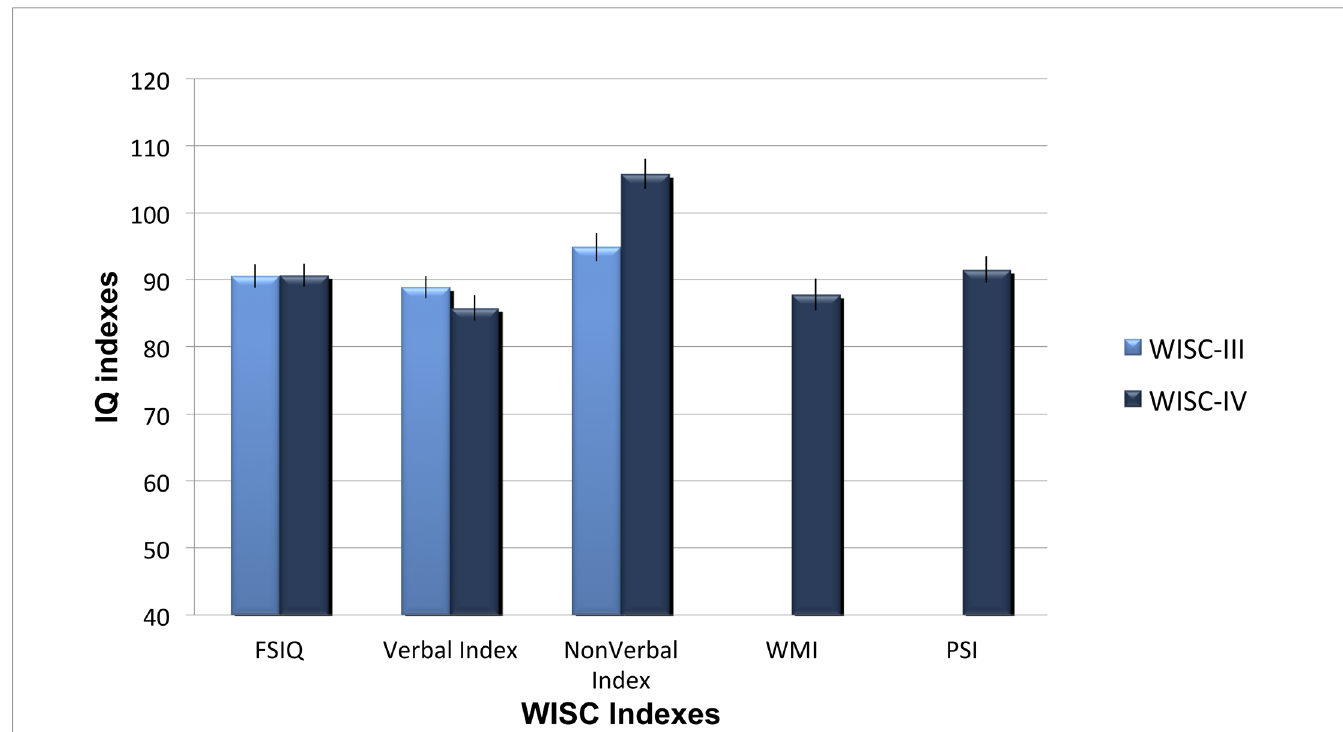
Fig 1. Autistic WISC-III and -IV IQ indexes. Mean standard scores on WISC-III and WISC-IV indexes. FSIQ: Full Scale IQ; Verbal: Verbal Comprehension Index in WISC-IV and Verbal Index in WISC-III); NonVerbal IQ: Perceptual Reasoning Index in WISC-IV and Performance IQ in WISC-III; WMI: WISC-IV Working Memory Index; PSI: WISC-IV Processing Speed Index. Error bars represent standard error from the mean.